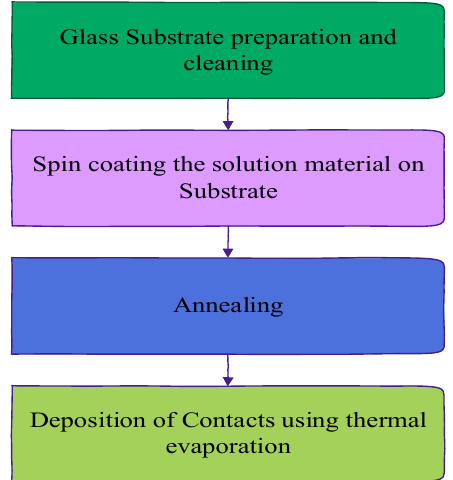
Figure 13. Fabrication methodology for multi-junction polymer and hybrid solar cell.